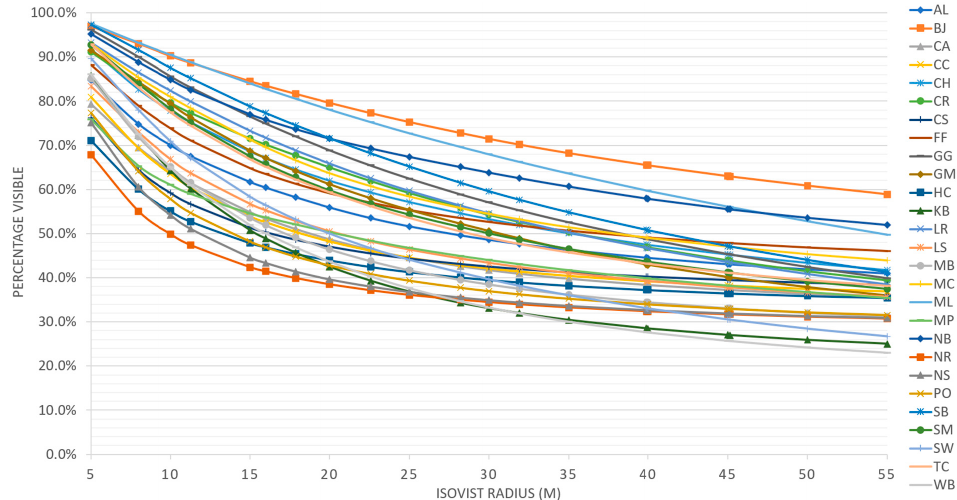
Figure 9. Average percent visible of area for each stand as measured by isovists. Area visible uniformly decreased as the radius of the isovist increased.